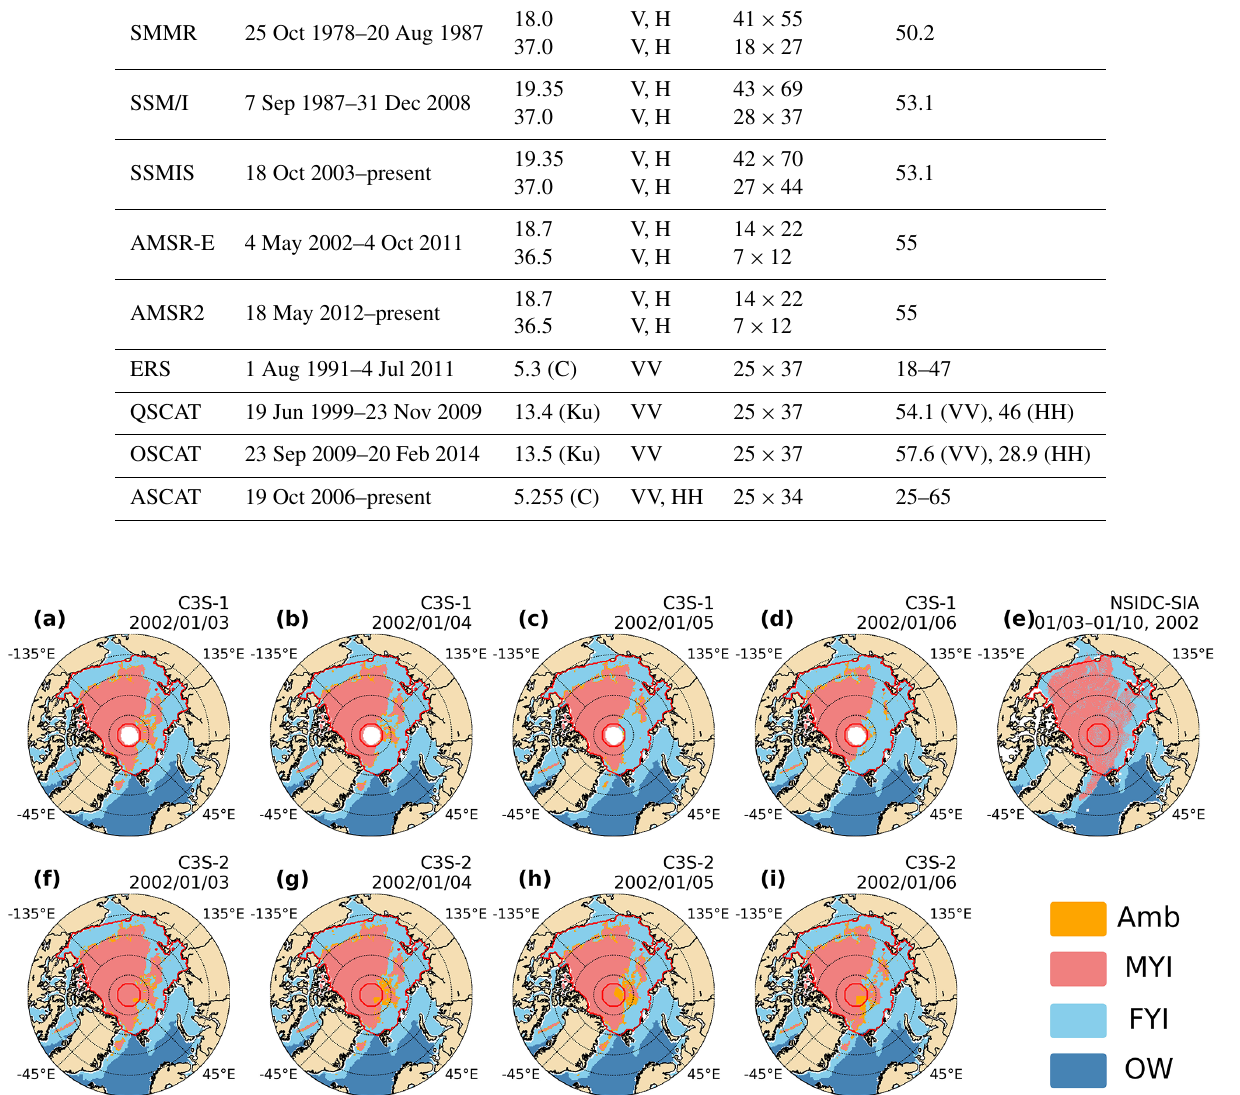
Figure A1. Arctic SITY distribution maps from daily SITY product C3S-1 (a–d) and C3S-2 (f–i) and weekly NSIDC-SIA (g) from 3 to 6 January 2002.